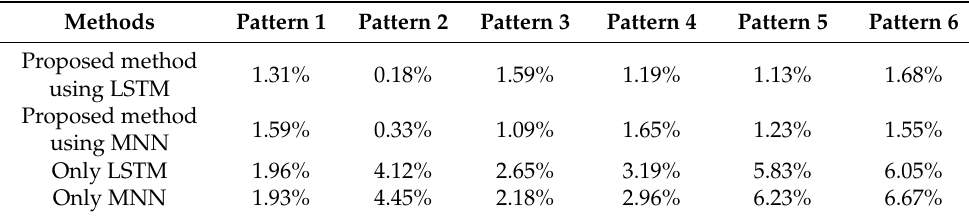
Table 4. The SOC estimation error for each model when one voltage parameter was input.